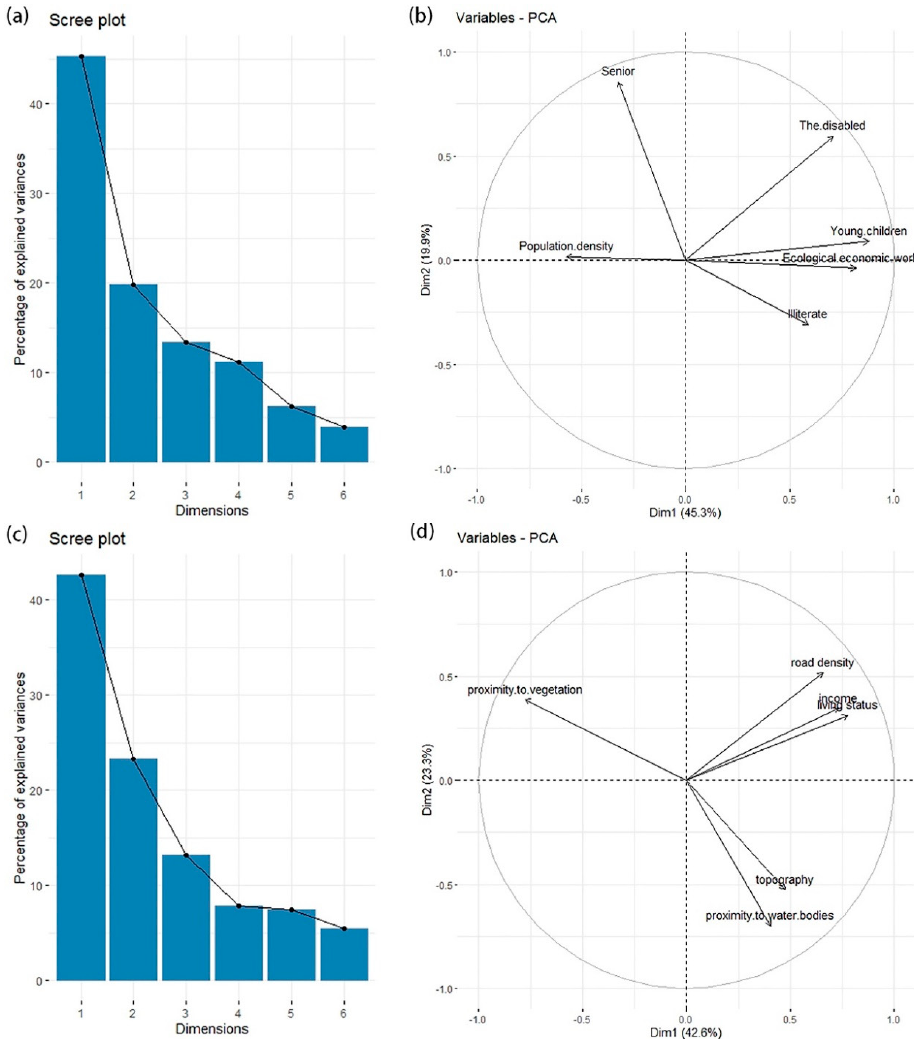
Figure A2. Scree plots and loading factor plots of ( a ) and ( b ) population variables; ( c ) and ( d ) heat vulnerability and adaptation variables.